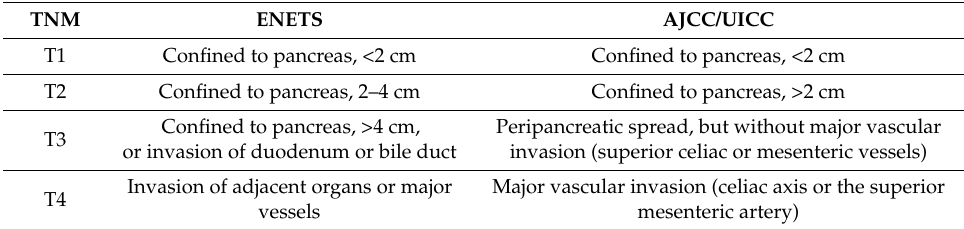
Table 2. Comparison of the criteria for the T category in the ENETS and UICC TNM classifications of pancreatic neuroendocrine tumors